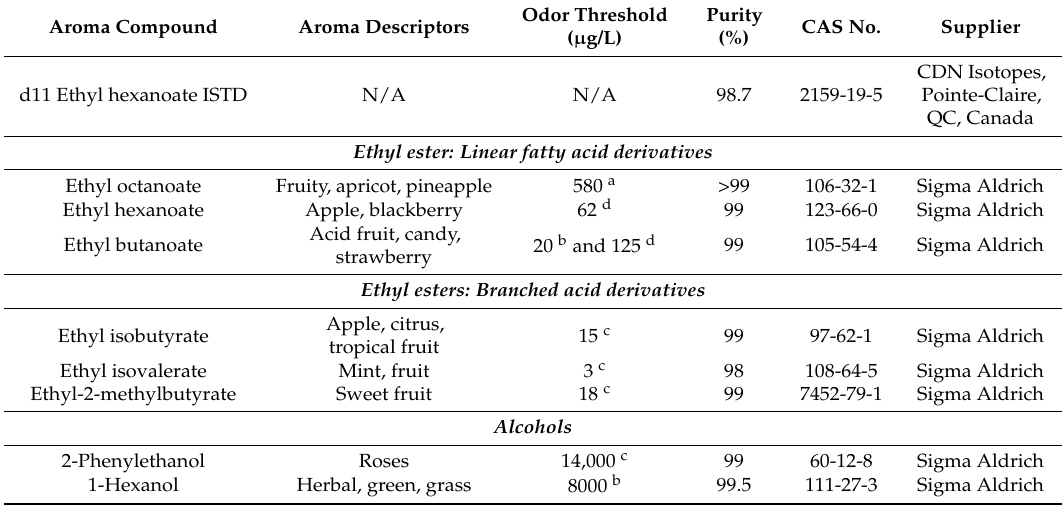
Table 1. List of volatile aroma compounds analysed, their aroma descriptors and odour